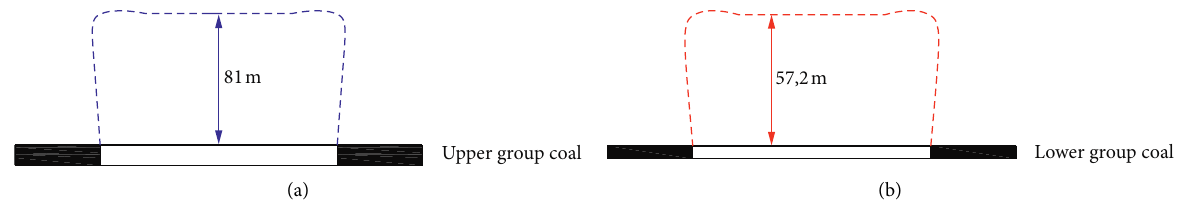
Figure 1: Expansion height of water-conducting fracture zone in grouping mining. (a) Expansion height of water-conducting fracture zone in the upper group coal mining. (b) Expansion height of water-conducting fracture zone in the lower group coal mining.